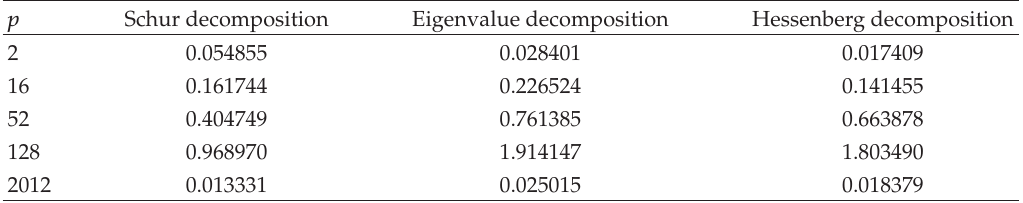
Table 2: Comparison time in seconds for computing the p th root of Random